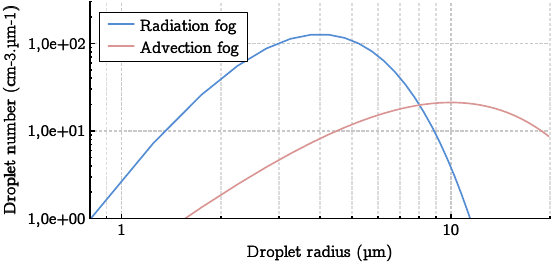
Figure 1. Droplet size distribution models for radiation and advection fogs with V = 50 m